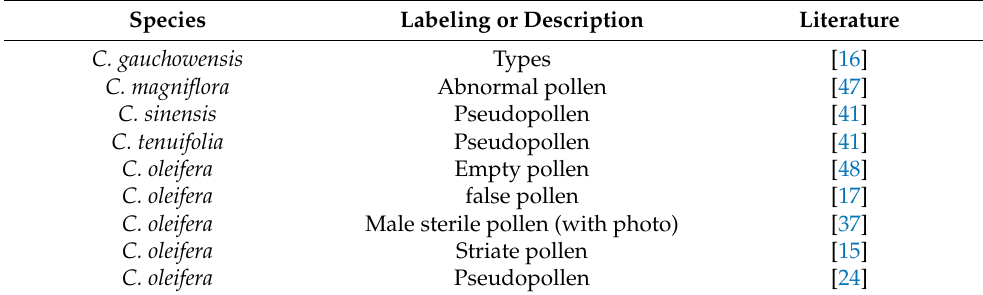
Table 2. Part of the misjudgment or explanation about the research on the stomium cells of Camellia anthers. Species Labeling or